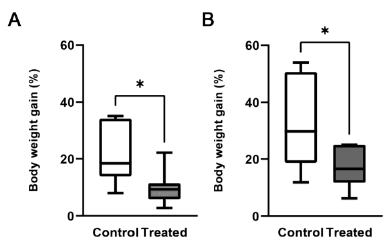
Figure 1. Body weight gain. Mice were fed either a normal (control) or a Mg-deficient diet (treated). Body weight gain was calculated after 4 weeks ( A ) and 8 weeks ( B ) as % of the initial value. Data (n = 7 for each group) are presented as, box-and-whisker plots- (Center line, median; box limits, first and third quartiles; whiskers, max-min). * Significant differences of the treated group vs. the control group ( p < 0.05).